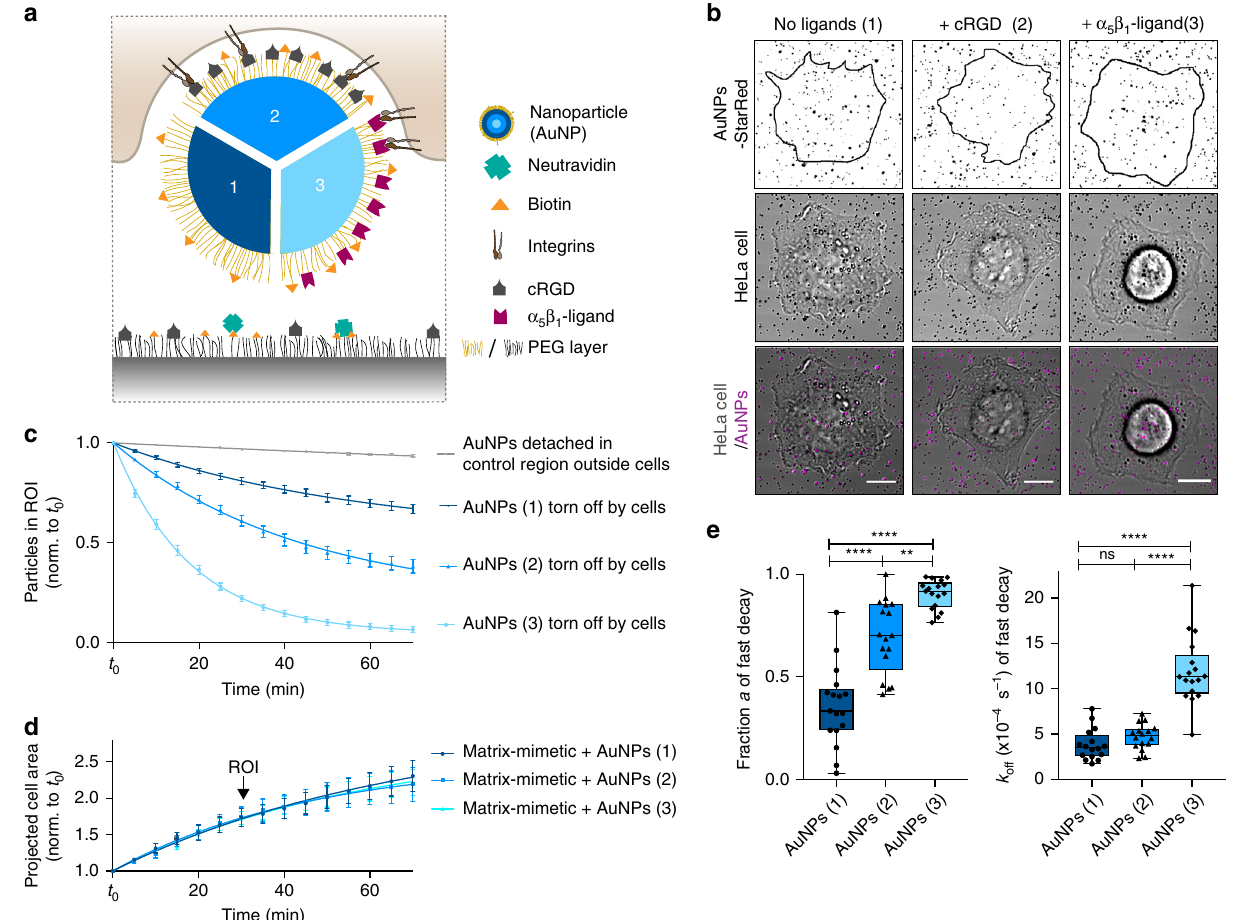
Fig. 4 Receptor-ligand interactions enhance nanoparticle uptake from the ventral cell side. a Schematic of a cell tearing off a biotin-neutravidin bound nanoparticle (AuNP) either only passivated with PEG (1) or additionally functionalized with cRGD (2) or integrin α 5 β 1 selective ligands (3). b Confocal images of a HeLa cell (transmission) spreading and tearing off StarRed- fl uorescently labeled AuNPs (magenta) from the surface at t = t 0 + 70 min with ROIs 1 h post seeding. Scale bars, 10 µ m. c Relative number of particles in the ROI under the cells or in a control region outside the cells over time. Data are represented as mean ± s.e.m. and fi tted with two-phase decay functions. ( n = 3 control regions or 19, 24, 27 cells on AuNPs (1), (2) and (3), respectively, three technical replicates, data are represented as mean ± s.e.m. and fi tted with an exponential decay function). d Projected cell area normalized to t 0 of cells spreading on the matrix-mimetic surfaces decorated with AuNPs 1 – 3 over time with exponential fi ts. e For the particles being actively removed by the HeLa cells, the fraction a and the off rate k off are shown as obtained by fi tting from the two-phase-decay of particles in the ROI as presented in ( c ). (Box- plots represent median± 95% CI with whiskers to the min and max values, ** P < 0.001, **** P < 0.0001; one-way ANOVA with post hoc Tukey). Source data are provided as a source data